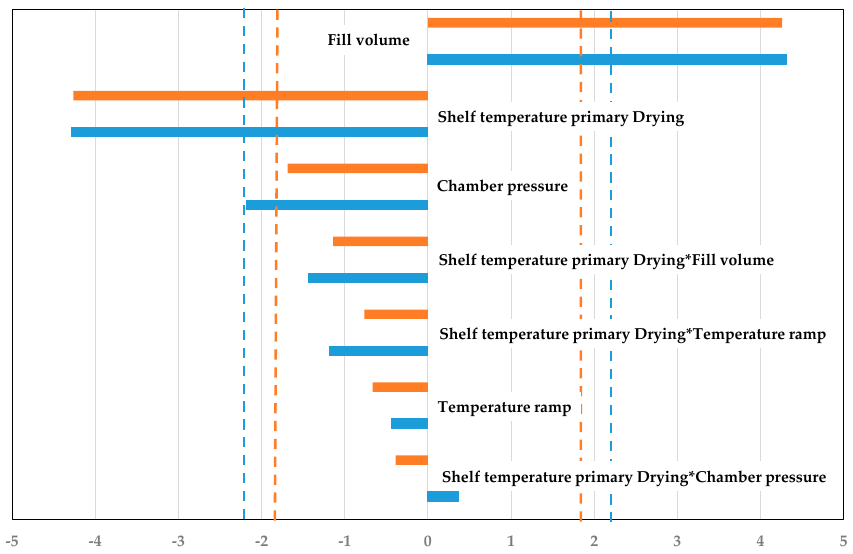
Figure 11. Pareto diagram of standardized effects for primary drying duration (blue: Experiment; orange: Simulation, dashed line: significance threshold).